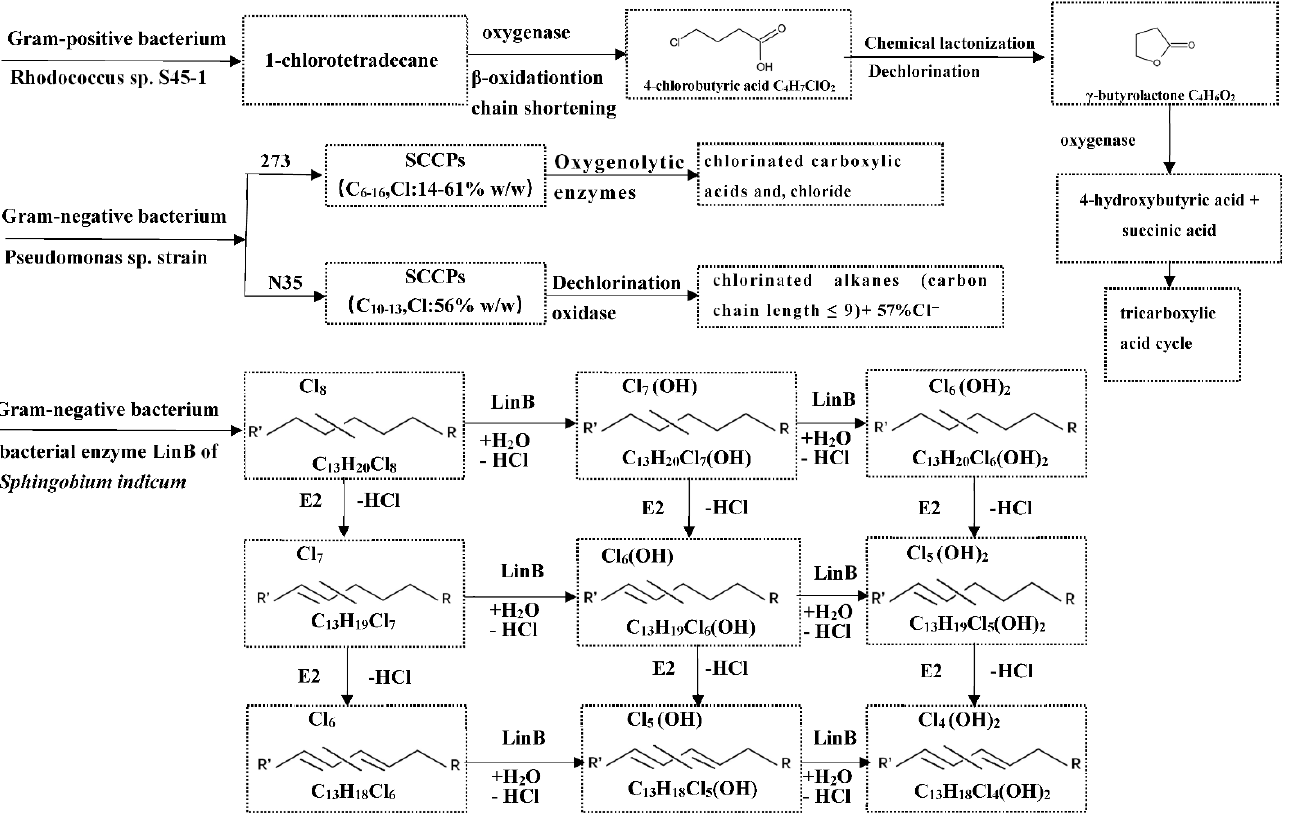
Figure 2. The transformation pathways of 1-chlorotetradecane, SCCPs (C6 – 16, Cl: 14 – 61% w / w ), SCCPs (C10 – 13, Cl: 56% w / w ), and octachlorotridecanes mediated by Rhodococcus sp. S45-1, Pseu- domonas sp. Strain 273 and N35, and bacterial enzyme LinB of Sphingobium indicum, respectively.